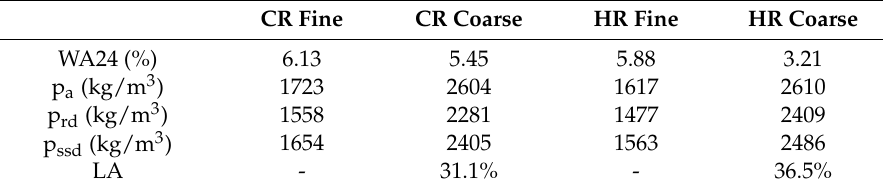
Table 3. Aggregate test results.